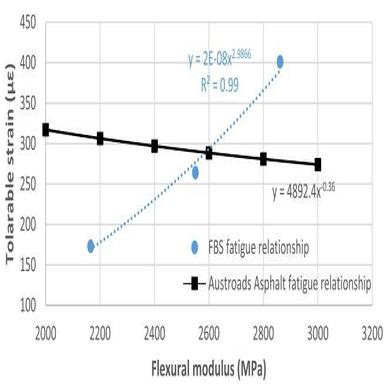
Comparison of tolerable strain values vs flexural modulus for asphalt (Vb = 6%) and FBS materials (when the flexural modulus is a function of temperature).